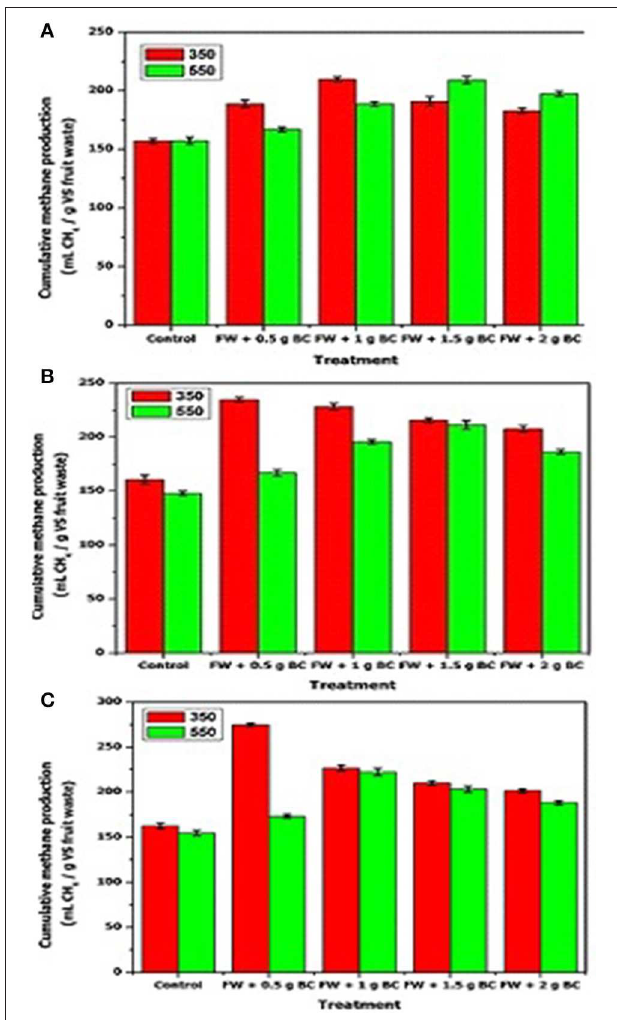
FIGURE 1 | Cumulative methane production in different AD treatments upon addition of different amounts of sludge biochar produced at: 350 ◦ C and 550 ◦ C, for (A) ISR = 2; (B) ISR = 1.5; (C) ISR = 1. Data are given as the arithmetic mean ± standard